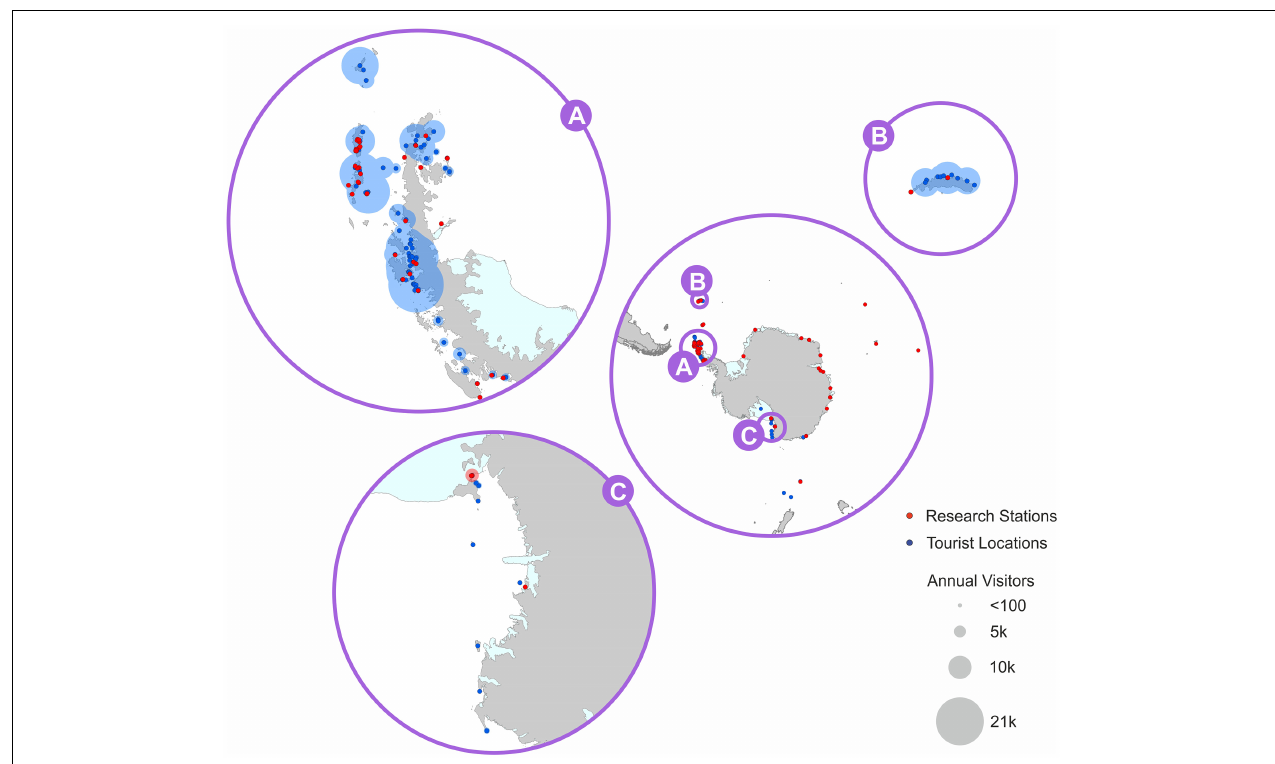
FIGURE 3 | Regions of highest land-based human activity (scientific research stations and tourist visits). Maximum occupancy of coastal Antarctic research stations (www.comnap.aq) and mean annual visitor numbers (2003/4-2014/15 seasons – IAATO) for Antarctica and the 2014/2015 season for South Georgia